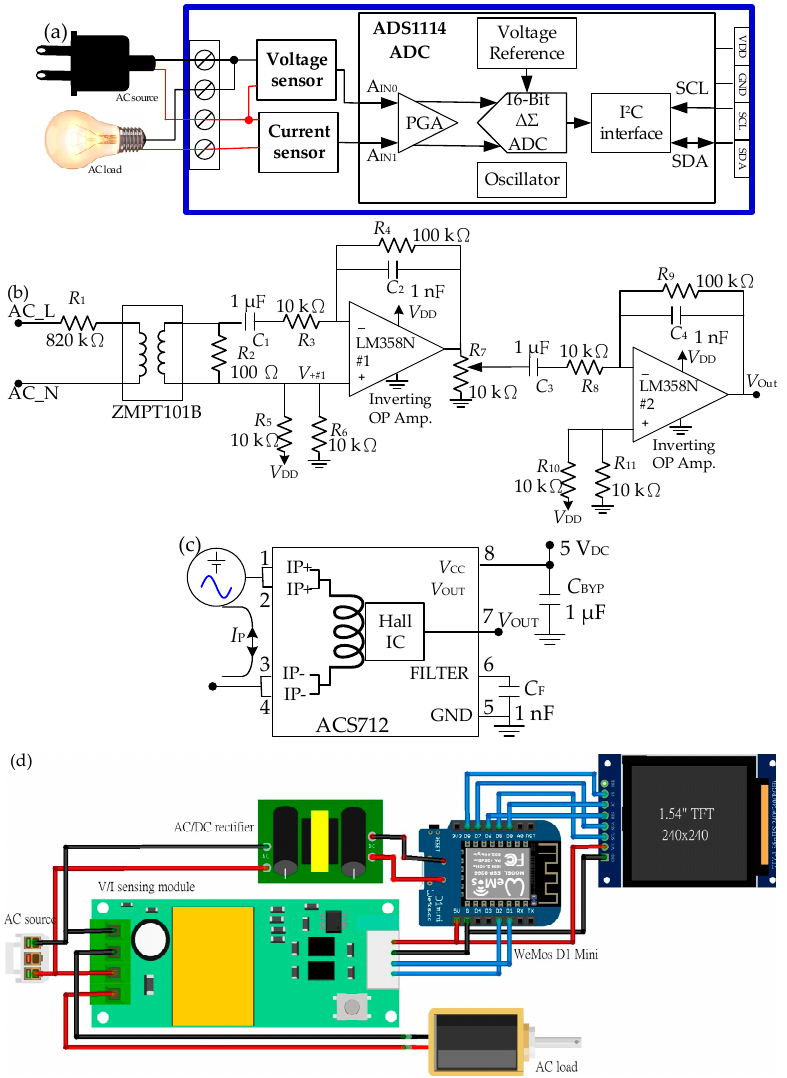
Figure 3. Circuit schematics: ( a ) AC V/I sensing module; ( b ) Voltage sensing module; ( c ) Current sensing module; ( d ) Wireless AC power monitoring module. Table 2. Main technical parameters of voltage and current sensors.